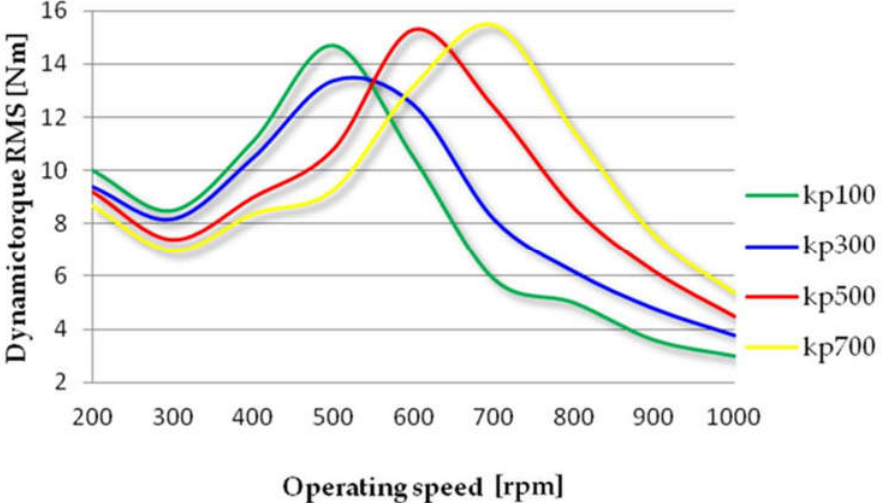
Figure 11. Measurement of variable resonance area for operating range—a run of all cylinders.